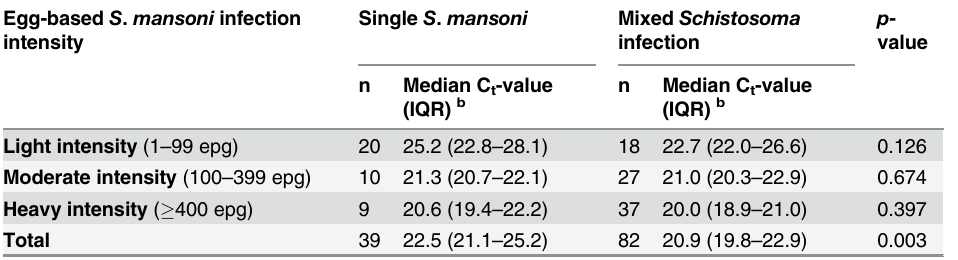
a Based on microscopy on 2 stool samples and (cid:3) 10ml of urine. b Median and IQR (interquartile range, calculated using Tukey ’ s hinges) are given for egg-positive and/or PCR-positive individuals